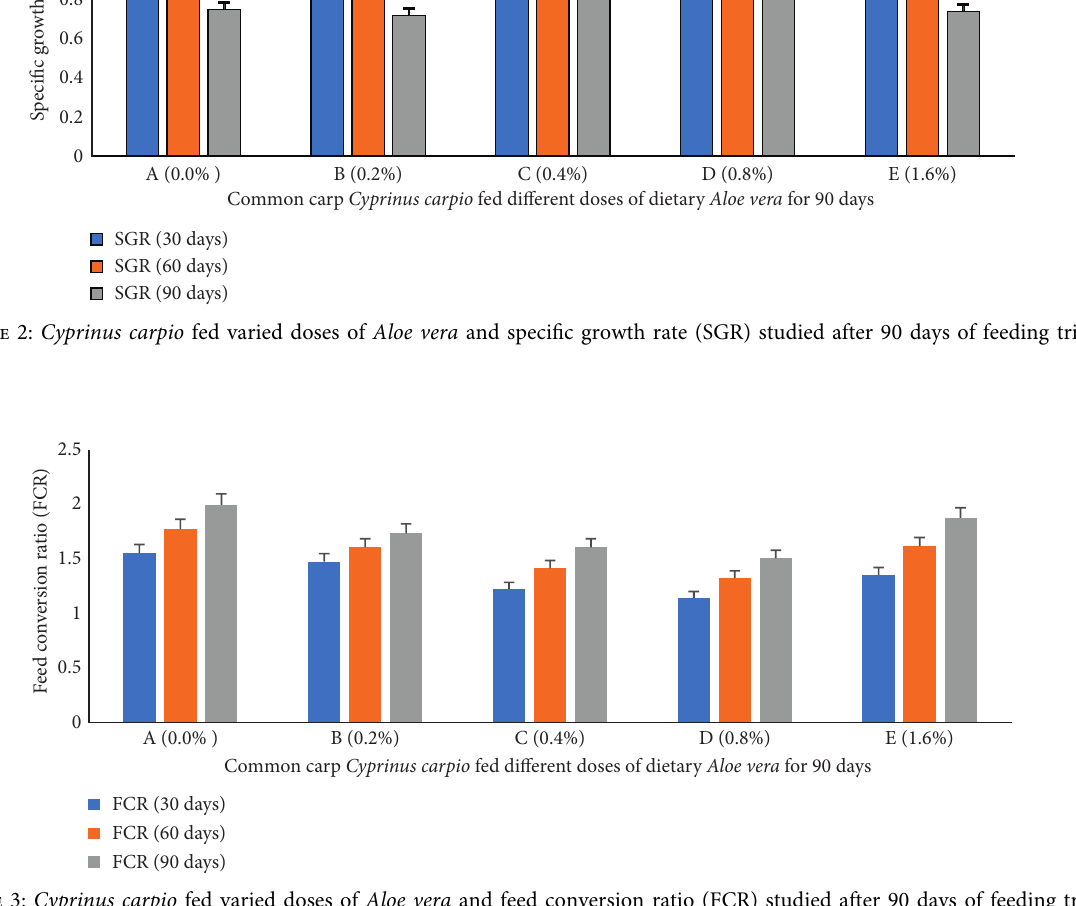
Figure 3: Cyprinus carpio fed varied doses of Aloe vera and feed conversion ratio (FCR) studied after 90 days of feeding trial.